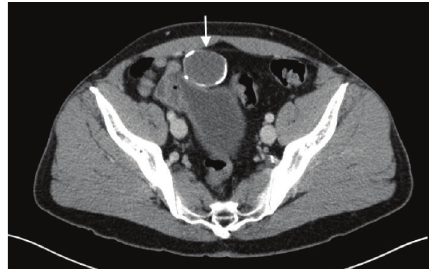
Figure 1: Computed tomography scan showing a cystic lesion anterior to the bladder with calcification within the wall (arrow).